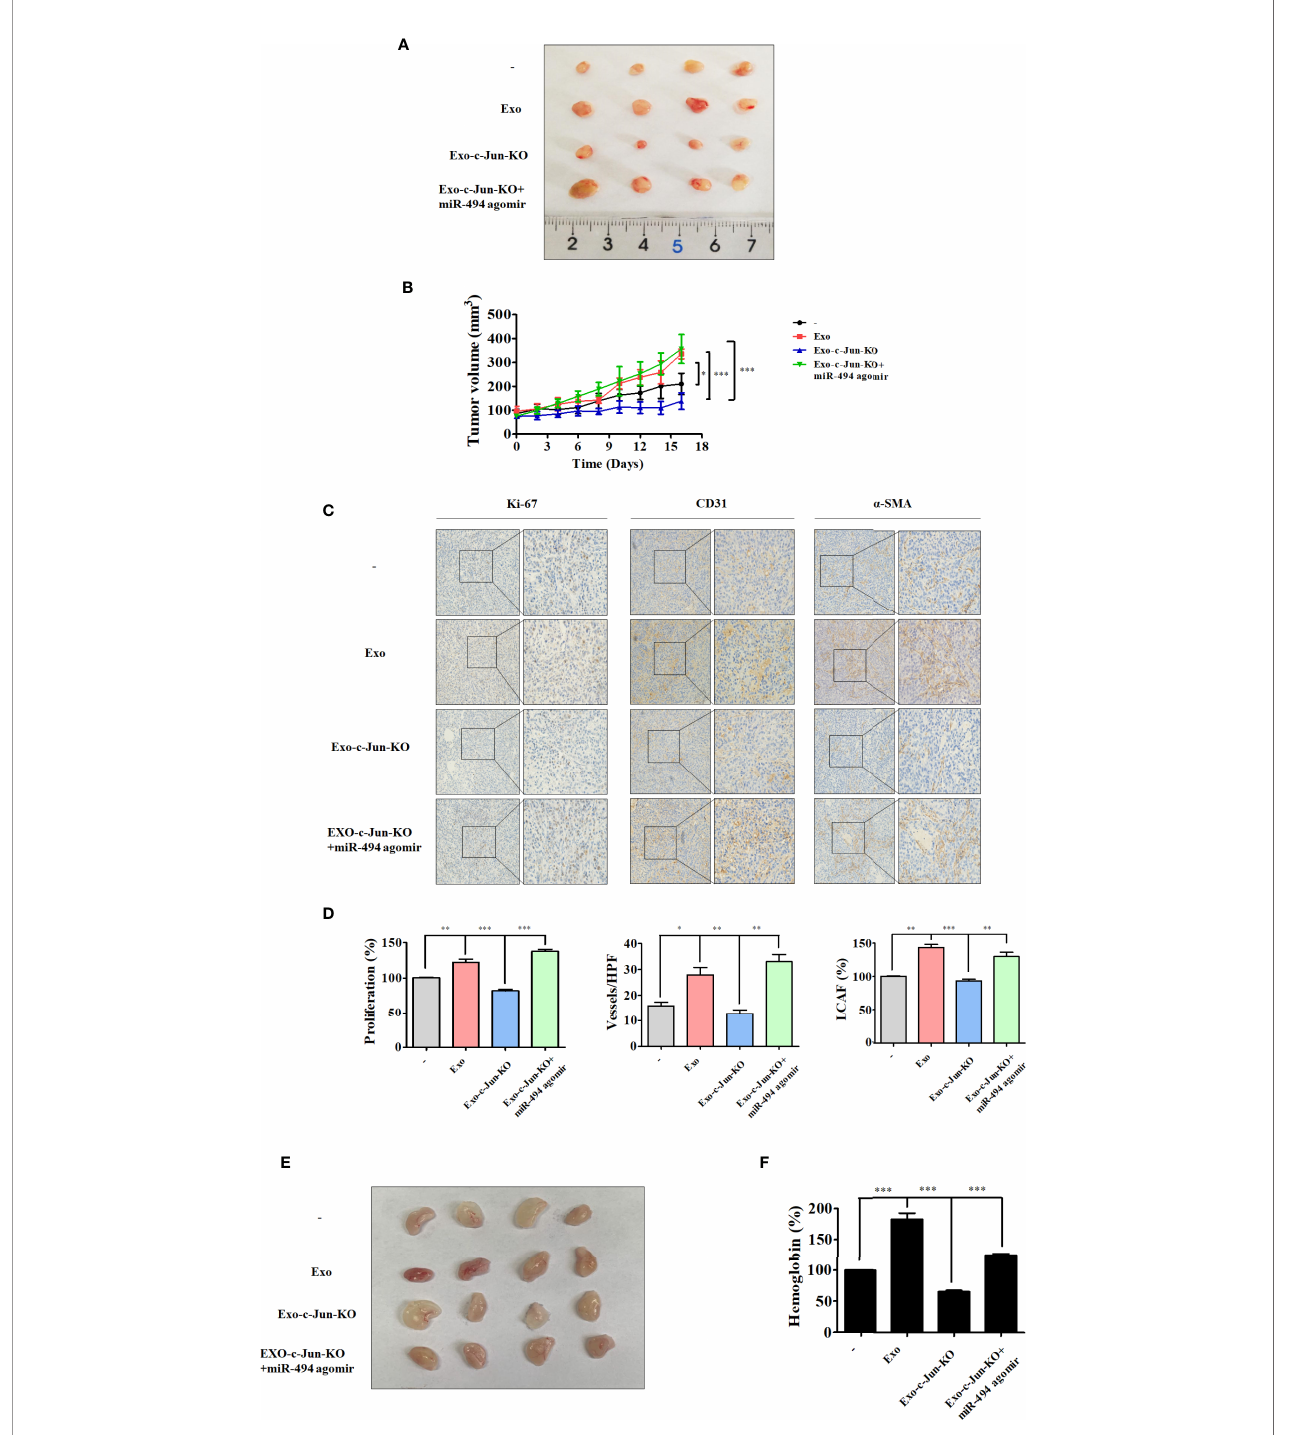
FIGURE 5 | Exo-c-Jun-KO suppresses lung cancer growth and angiogenesis in vivo A549 cells were inoculated subcutaneously in the fl ank site of nude mice. Exo, Exo-c-Jun-KO, miR-494 agomir were intratumorally injected every other day for 14 days. After 16 days, the tumors were excised from mice. (A) Representative images of the tumors removed from nude mice. (B) Quanti fi cation of tumor volume. Tumor volumes were measured every other day starting from the day before the fi rst treatment. (C, D) Immunohistochemical staining of Ki-67, CD31 and a -SMA in tumor tissues of different groups and their quanti fi cation. (E) Photos of the matrigel plugs from nude mice after various treatments. (F) Hemoglobin level in the matrigel plugs. Data show the mean ± SD (n=4). *p < 0.05, **p < 0.01, and ***p <